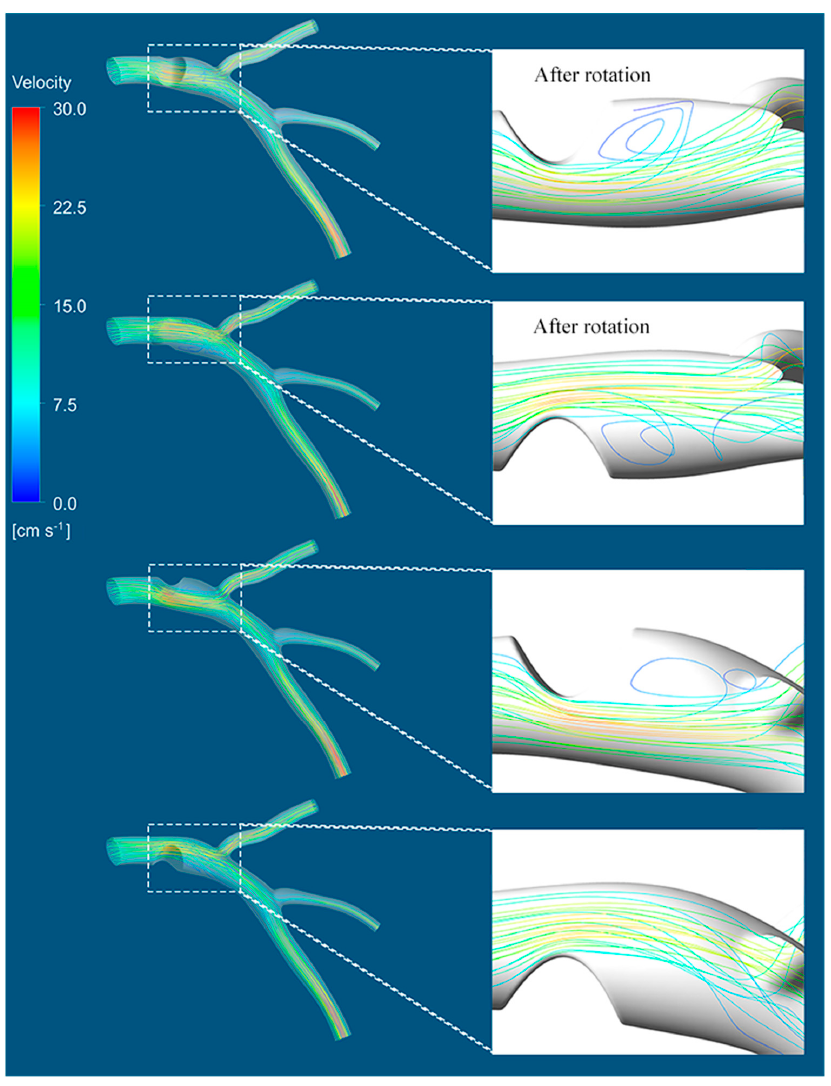
Figure 8. Velocity streamline diagram of the peak systolic phase.